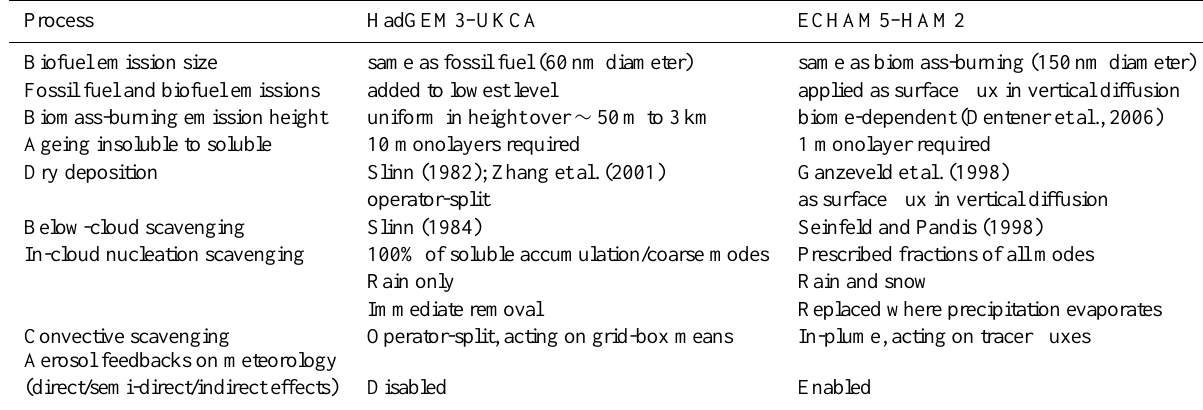
Table 1. Differences relevant to black carbon between the aerosol schemes in HadGEM3–UKCA and ECHAM5–HAM2, in their BASE